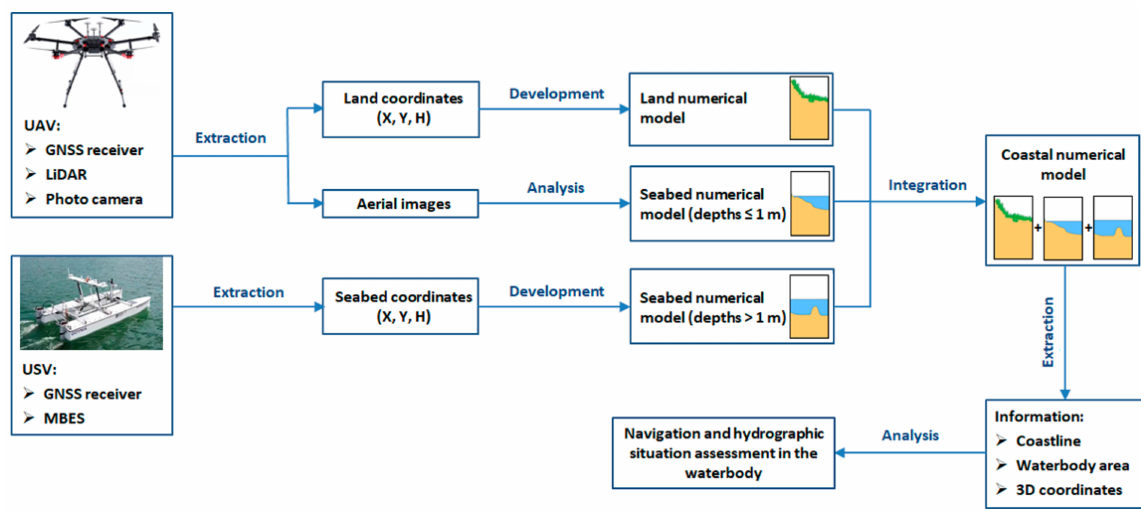
Figure 5. A diagram of the operation and functioning of an innovative autonomous unmanned system for bathymetric monitoring of shallow